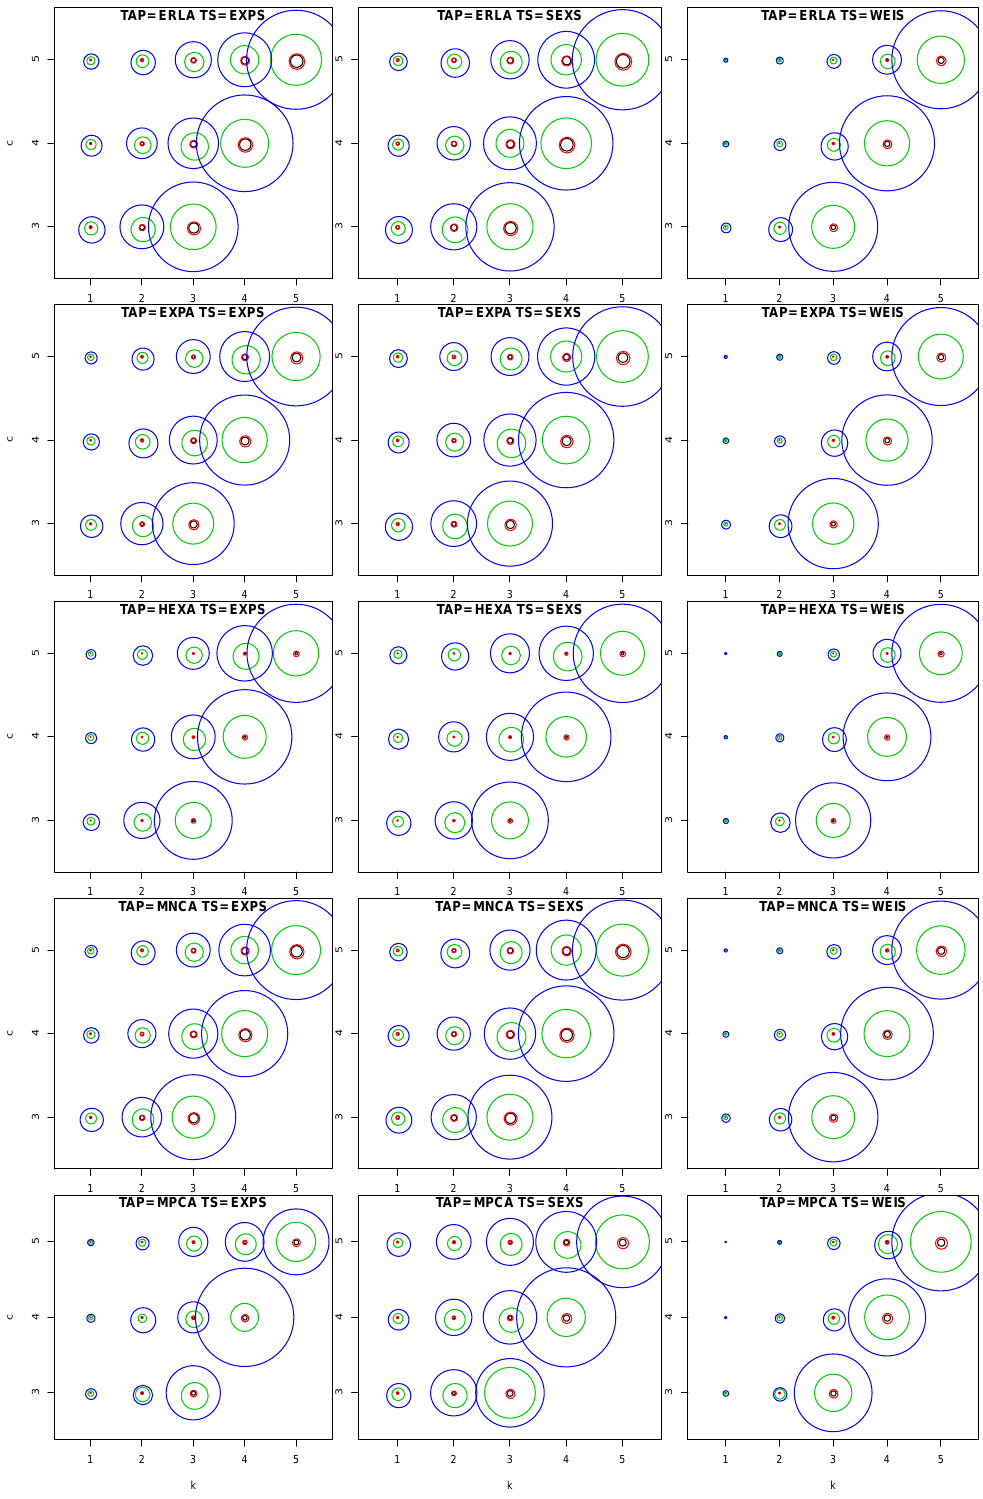
Figure 7: Plot of E ( L ) under various scenarios when c = 3, 4, 5 and k = 1, . . . , c for ρ = 0.2, 0.5, 0.9, 0.95 (black, red, green, blue circles correspondingly). Radius of the circle is proportional to the E ( L )